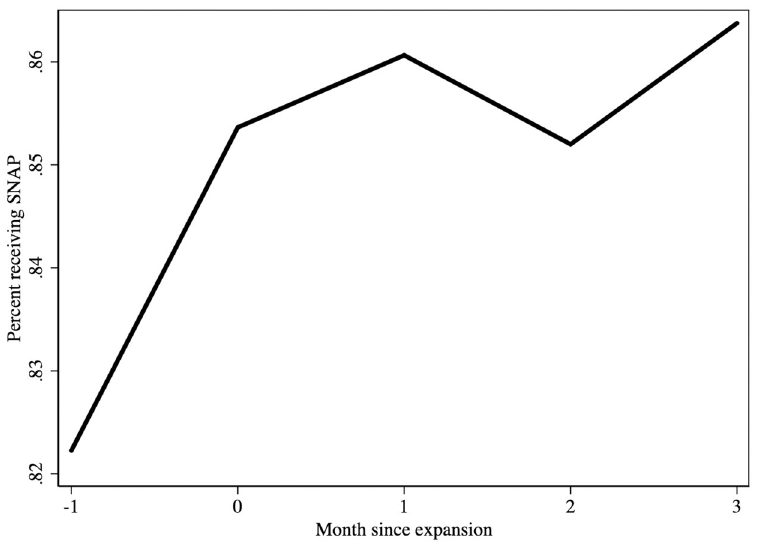
Fig 3. SNAP receipt patterns relative to Medicaid expansion month. Data source is the Current Population Survey December Supplement, 2014–2016. Includes only individuals reporting SNAP receipt in state-years with non-January Medicaid expansions (IN, MI, NH, LA,